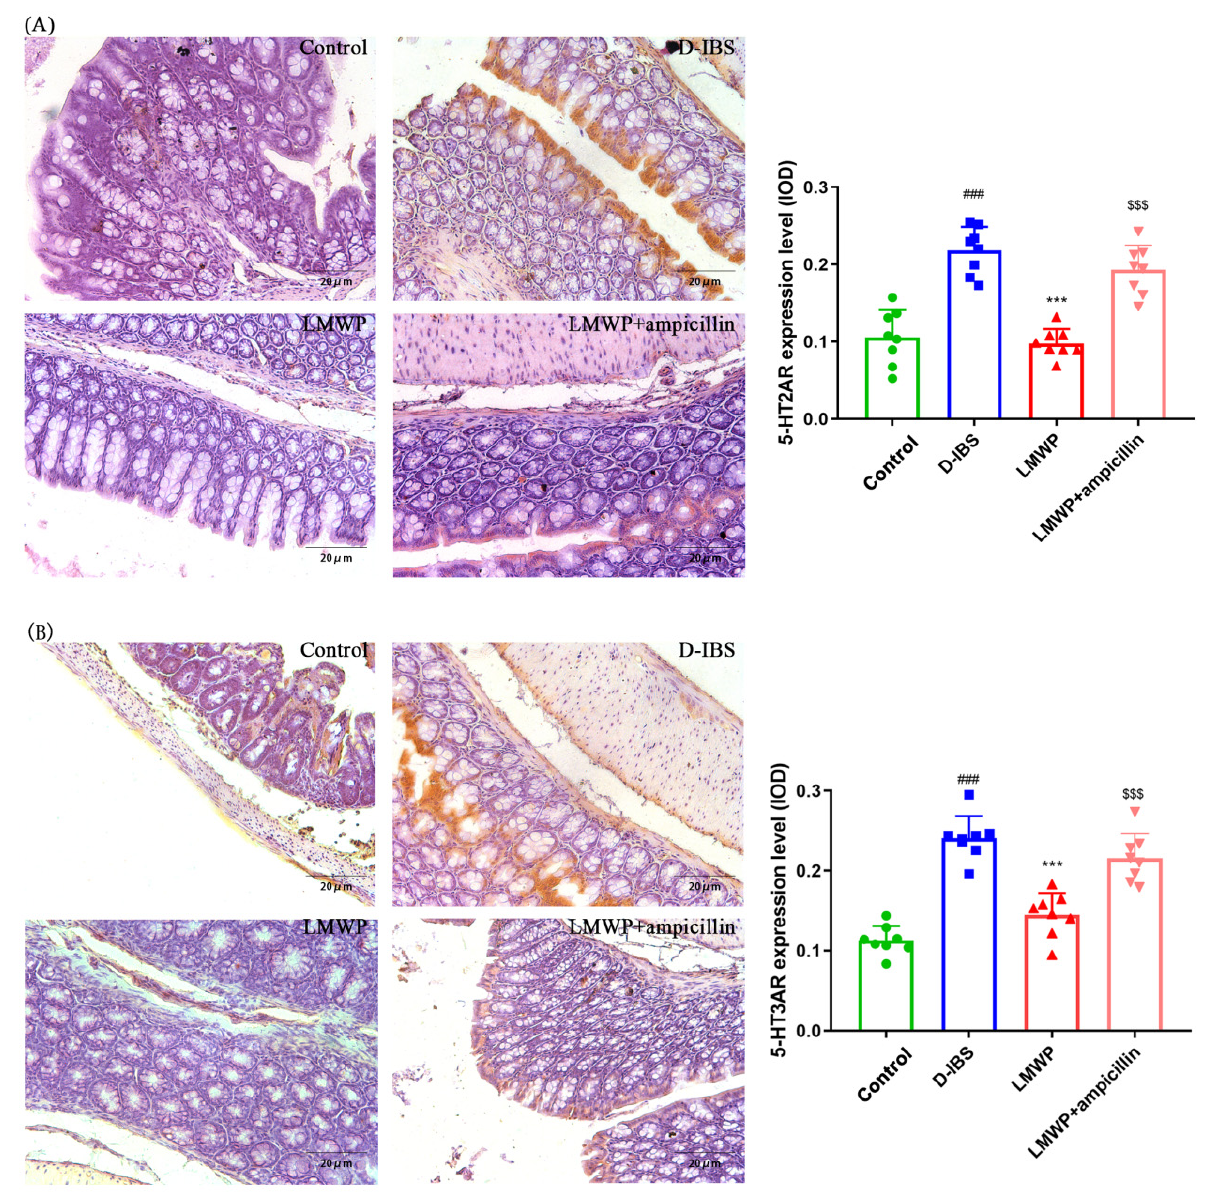
Figure 5. Immunohistochemical staining in the colon. ( A , B ) 5-HT2AR and 5-HT3AR. Values are presented as the means ± SD ( n = 8). ### p < 0.001 compared to Control, *** p < 0.001 compared to D-IBS and $$$ p < 0.001 compared to LMWP (S3-3) from the larvae of Musca domestica .